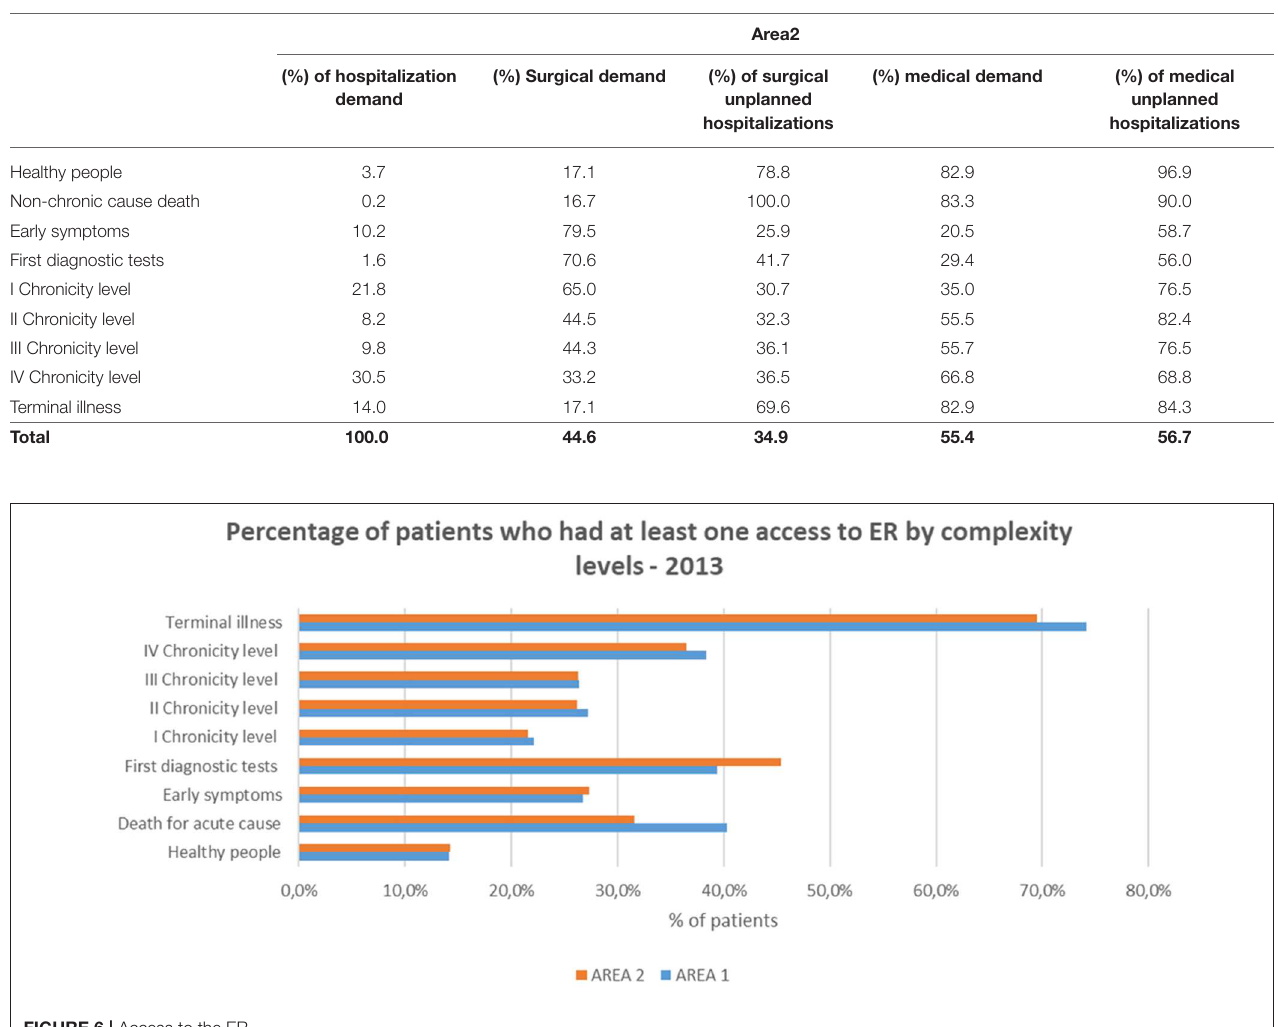
TABLE 2 | Overall hospitalization demand Area 2.